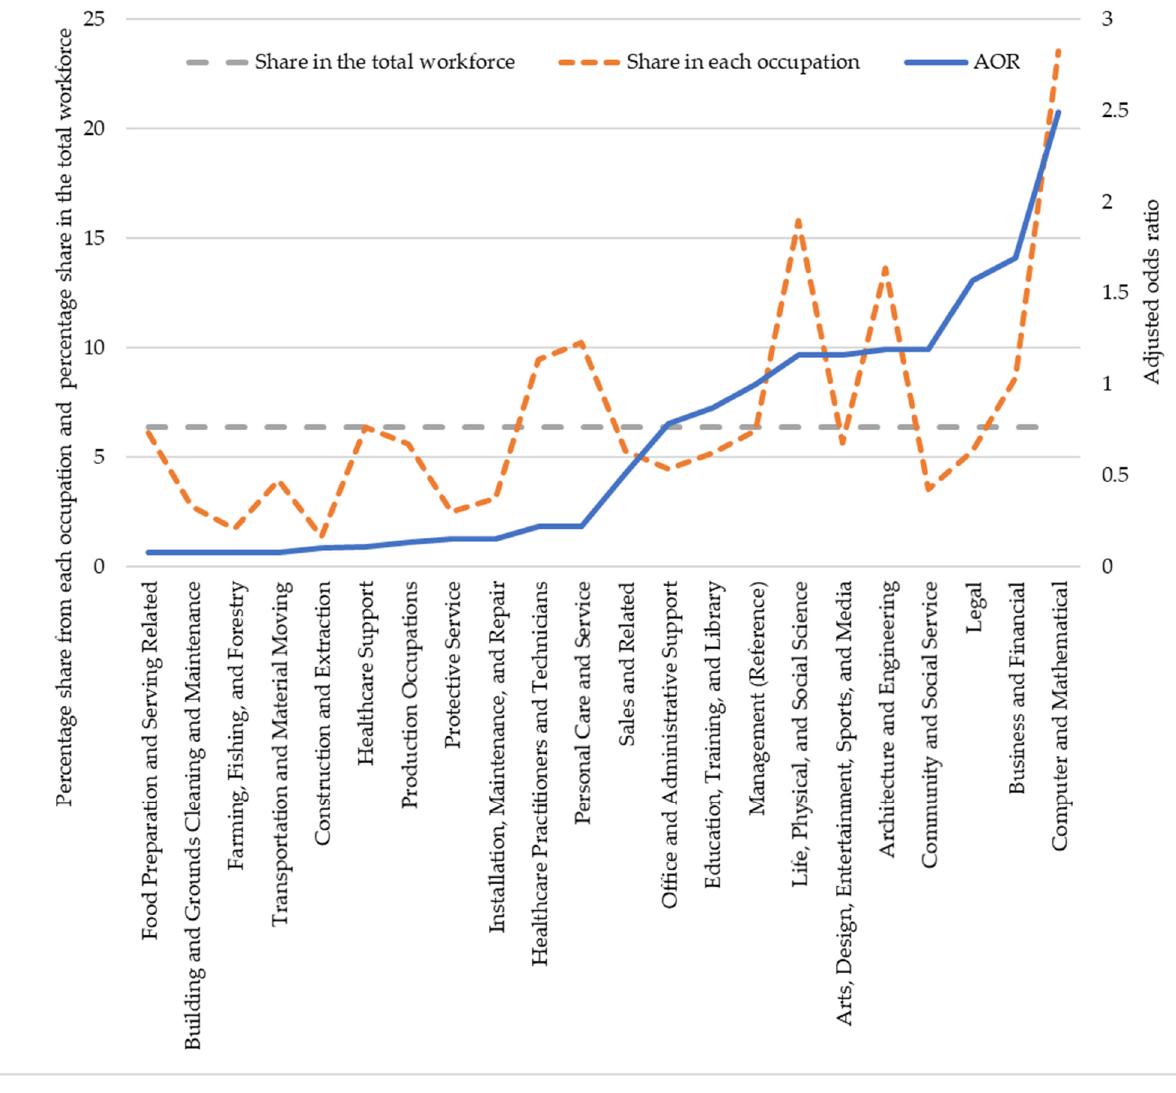
Figure 4. Adjusted odds ratio (AOR) of teleworking in each occupation and share of Asian workers in each occupation and in the total workforce.